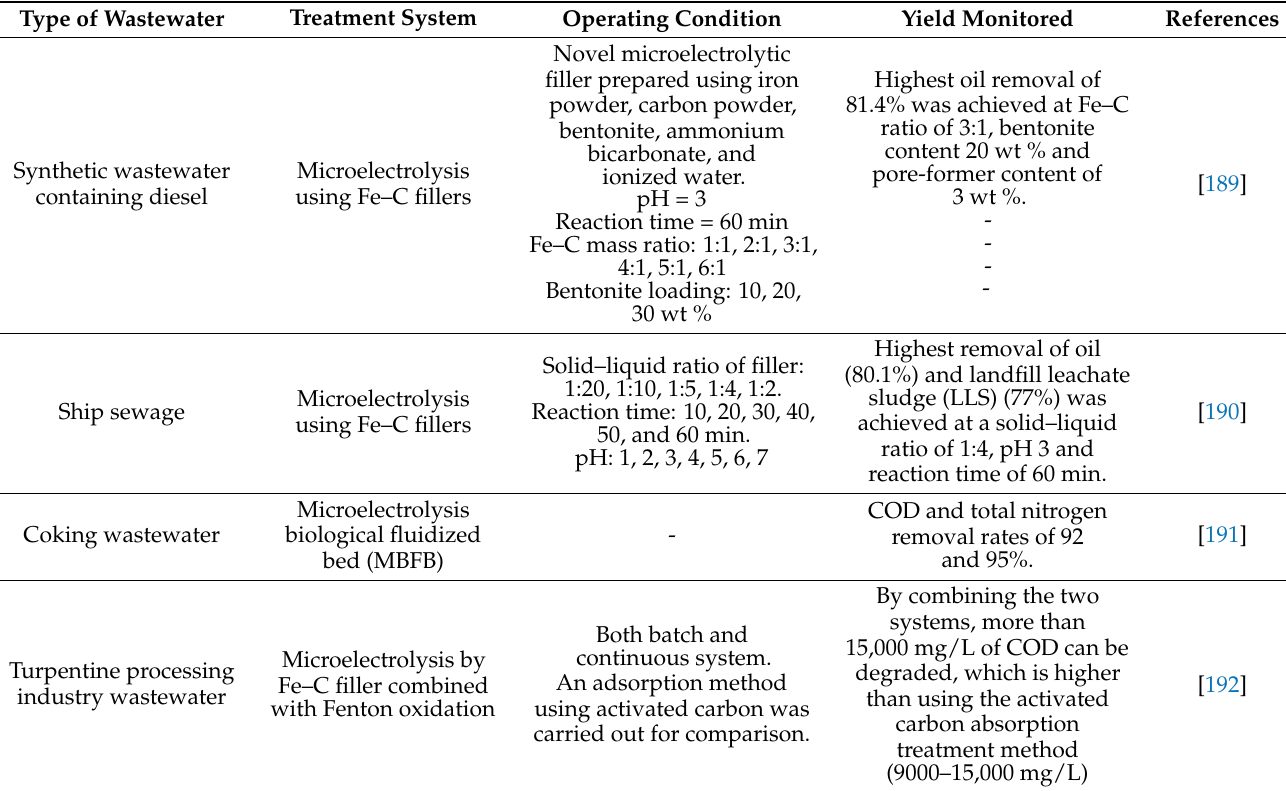
Table 8. Research on the effect of operating conditions on the performance of microelectrolysis oily wastewater treatments from 2018 to recent